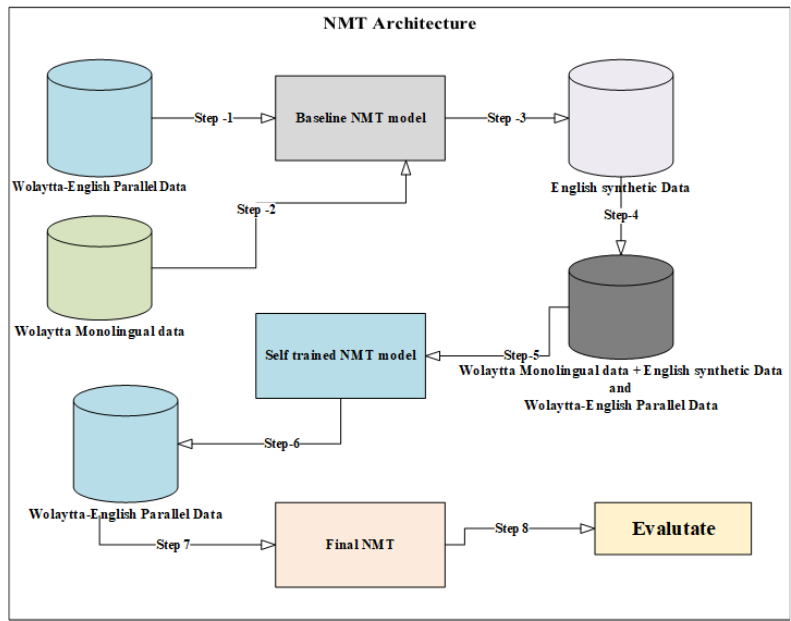
Figure 7. Experimental architecture of the Wolaytta–English NMT model.